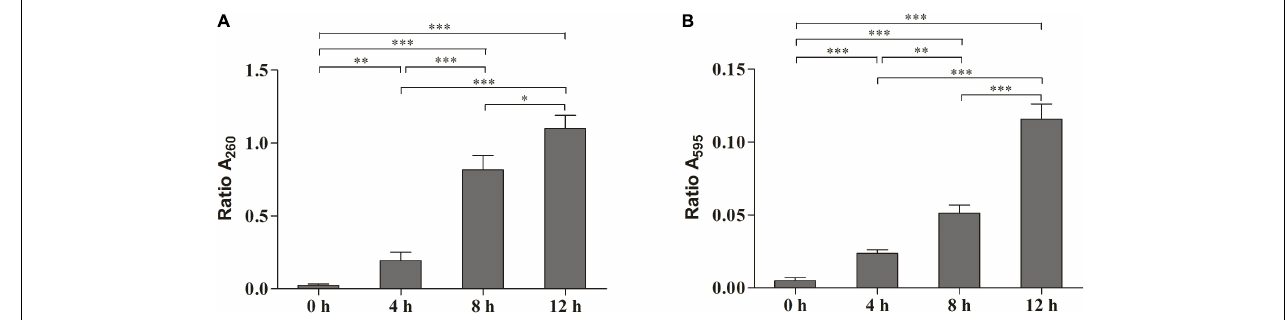
FIGURE 2 | The release of the intracellular material of A. hydrophila at different treatment times (0, 4, 8, and 12 h) in 1 × minimum inhibitory concentration (MIC) SMEO. (A) Change of the optical absorbance (A 260 ) of cell supernatant, which is an indicator of nucleic acids. (B) Change of the optical absorbance (A 280 ) of cell supernatant, which is an indicator of protein. ∗ , ∗∗ , and *** represent P < 0.05, P < 0.01, and P < 0.001.